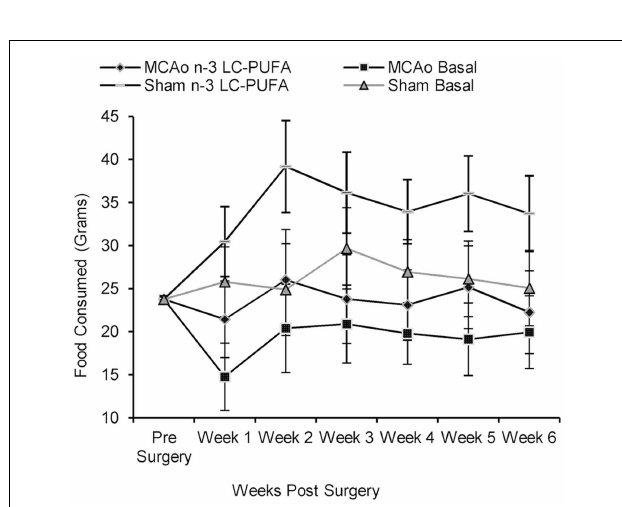
FIGURE 1 | Number of MCAo operated rats that experienced reperfusion related hemorrhage, between diet conditions . MCAo, middle cerebral artery occlusion surgery condition; Basal, basal diet fed rats; n -3-LC-PUFA, polyunsaturated fatty acid supplemented rats; n = 11 n -3-LC-PUFA MCAo; n = 0 basal MCAo.